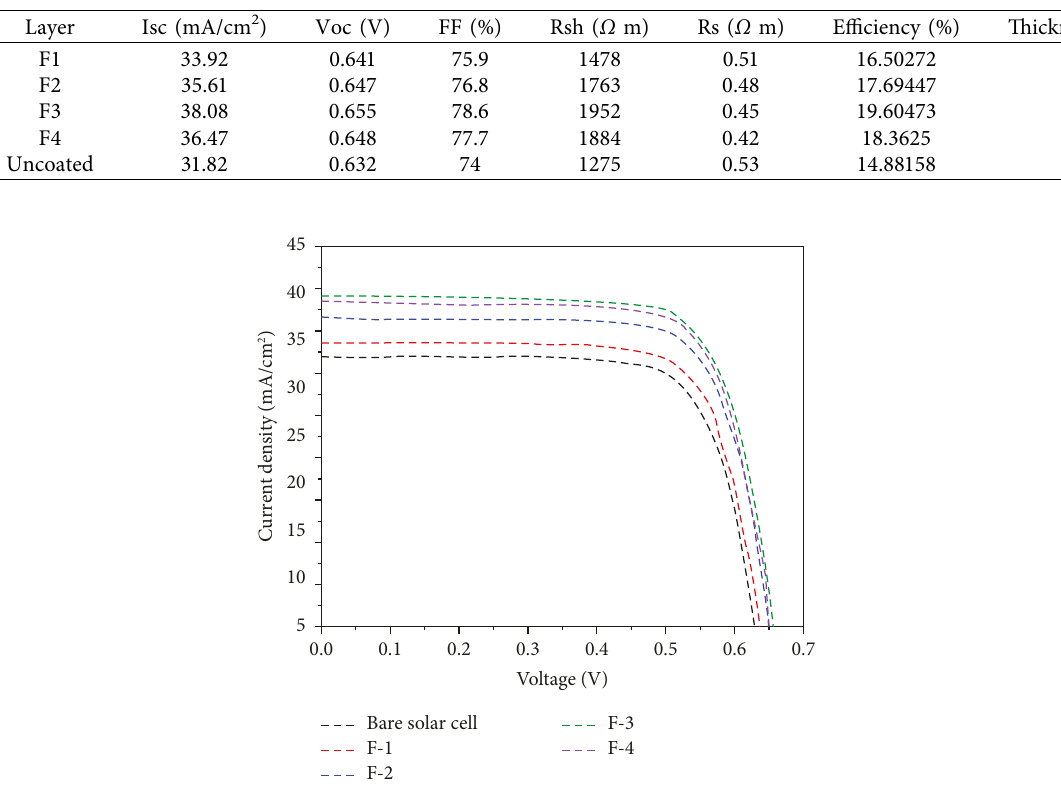
2 electrosprayed solar cells under neodymium light.